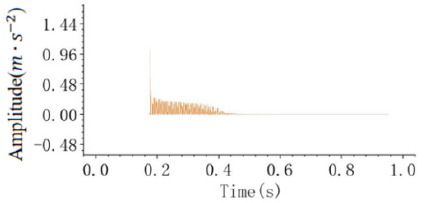
Figure 13. Time domain diagram of sparse decomposition results .